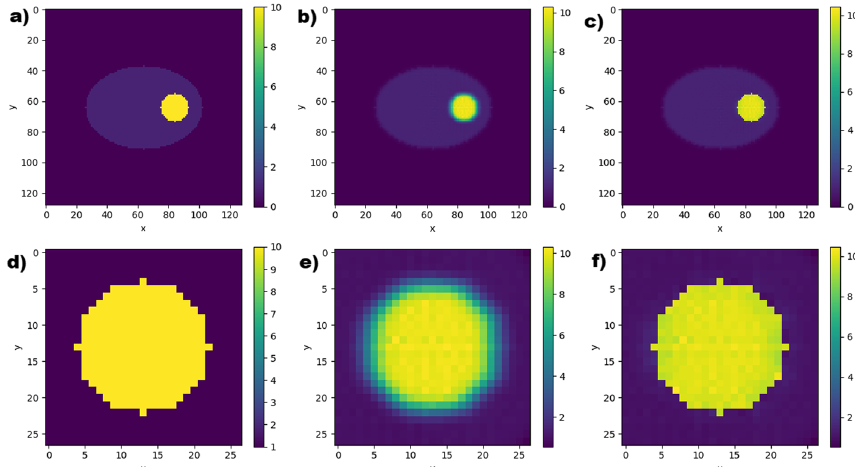
Fig. 8 a – c from left to right; ground truth, uncorrected and corrected images, in the transaxial plane, through the centre of a 36 mm radius lesion within the simple phantom using noise‑free data. d – f from left to right; local region around the lesion, zoomed in, on ground truth, uncorrected and corrected